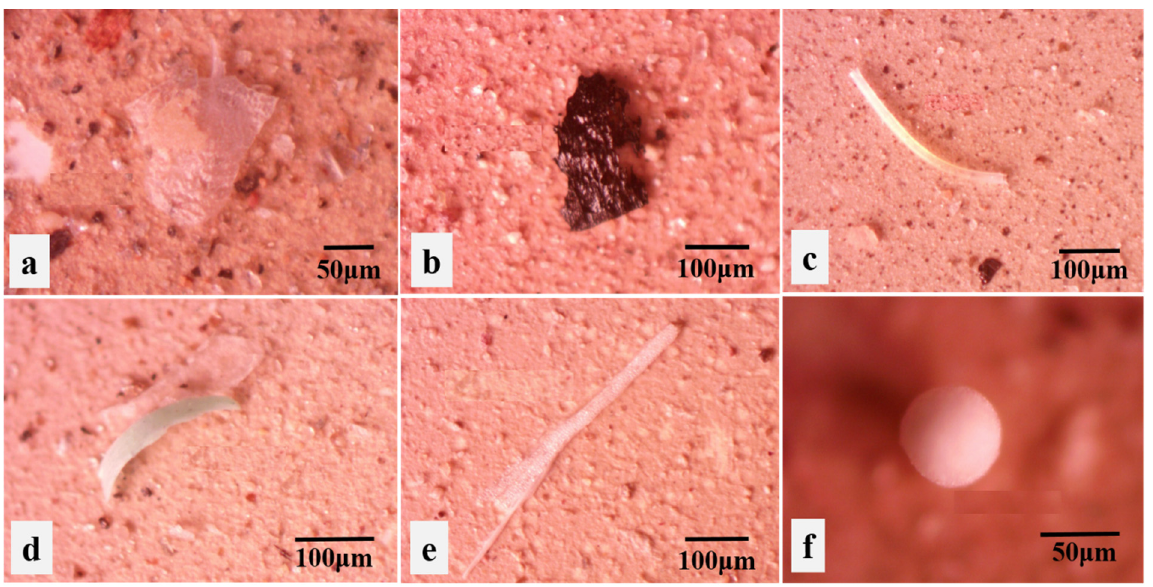
Figure 3. Typical microscopy images of MPs (films ( a , b ), fiber ( c ), fragment ( d ), foam ( e ), and granule ( f )).